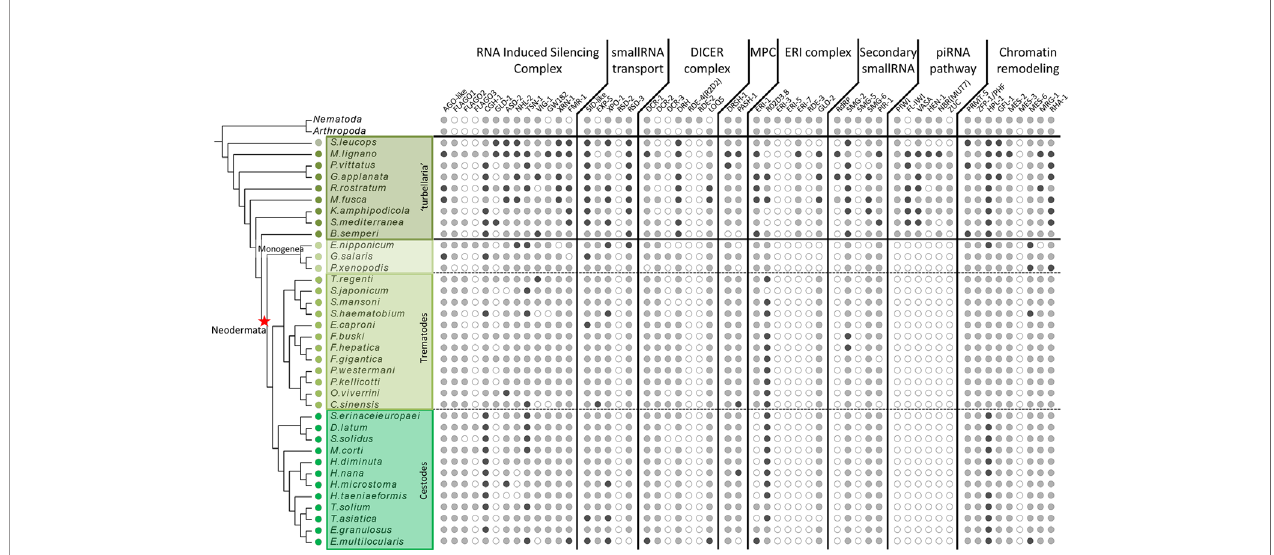
FIGURE 1 | Distribution of miRNA, piRNA and RNAi proteins across fl atworms, arthropods and nematodes. White circles indicate absence, grey circles indicate one homologue detected, black circles indicate two or more homologues detected. In arthropods and nematodes only presence/absence is